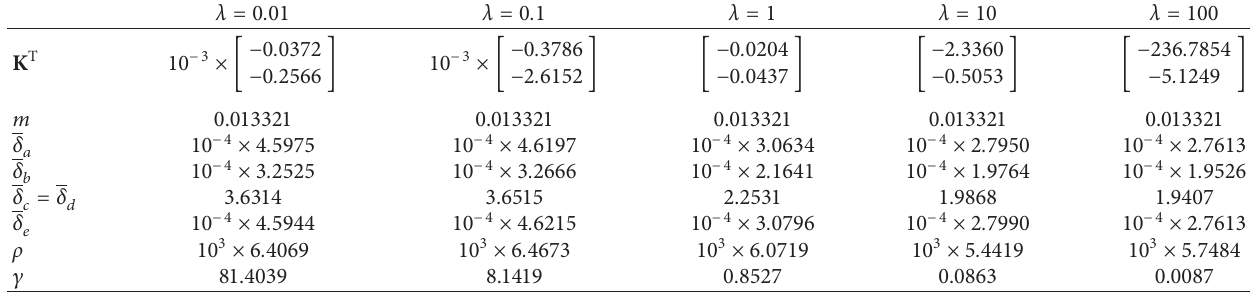
Table 1: Numerical simulation results obtained using the optimization algorithm in Theorem 3 for different values of the parameter λ and � 1. for u max